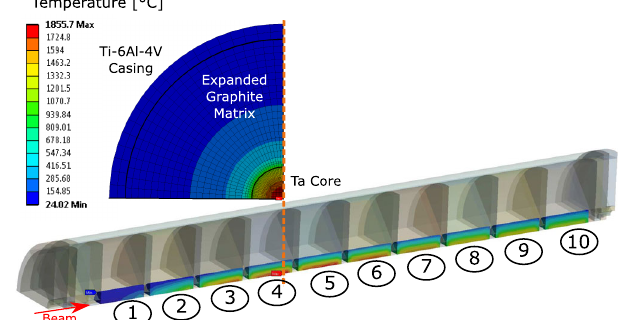
FIG. 6. Contour plot showing the temperature reached in the HRMT-42 target as a consequence of a proton beam impact.